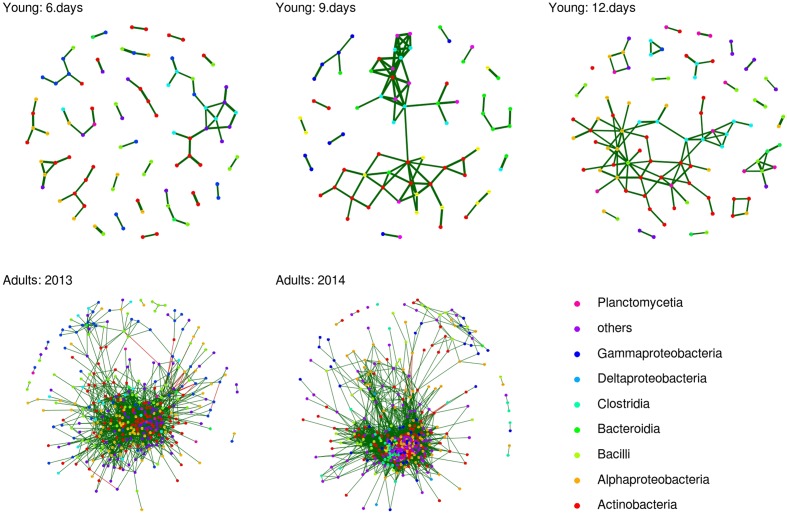
Operational taxonomic unit co-occurrence network for adult and juvenile barn swallow FM. OTU co-occurrence network based on nc.scores for individual age-classes and for adults. Only those nc.scores passing multiple testing corrections (q < 0.05) are shown. Green and red lines indicate positive and negative co-associations, respectively. Class-level taxonomic assignations of individual OTUs included in the analysis are highlighted in different colors.